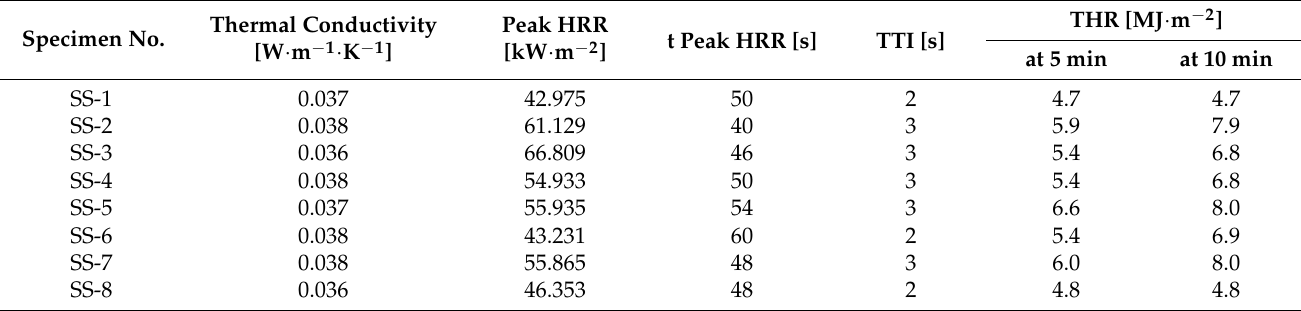
Figure 5. The specimen after 5 min of conducting the cone calorimeter method. Table 5. Results of FR-EPS samples according to the cone calorimeter